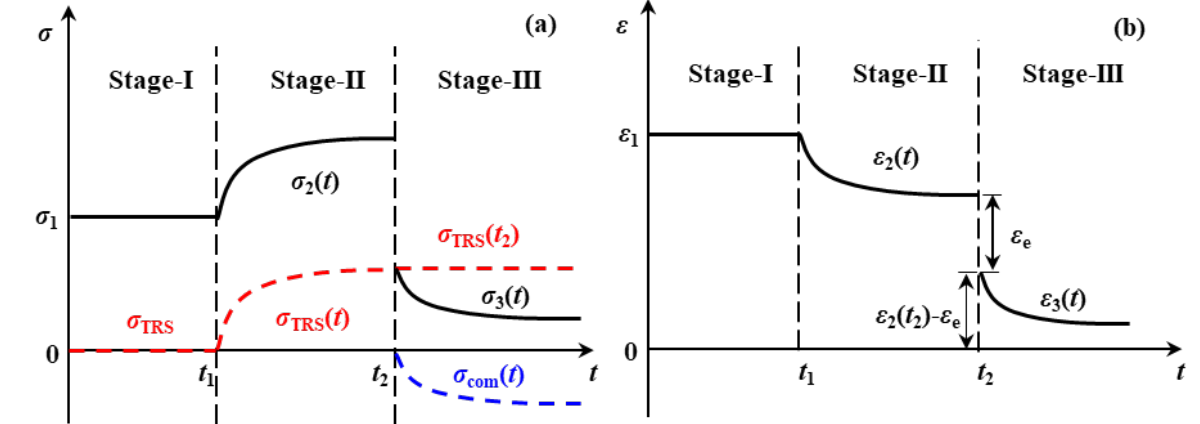
Figure 1. Schematic of production principle of EPPMC showing the ( a ) stress and ( b ) strain evolutions at three stages, where Stage-I is the fibre prestressing stage; Stage-II is the curing of matrix; and Stage-III is the post-processing stage. The continuous black line shows the in-plane ( a ) stress and ( b ) strain evolutions during production of an EPPMC. The dashed red/blue lines show the evolution of thermal residual stress/compressive stress within a composite.